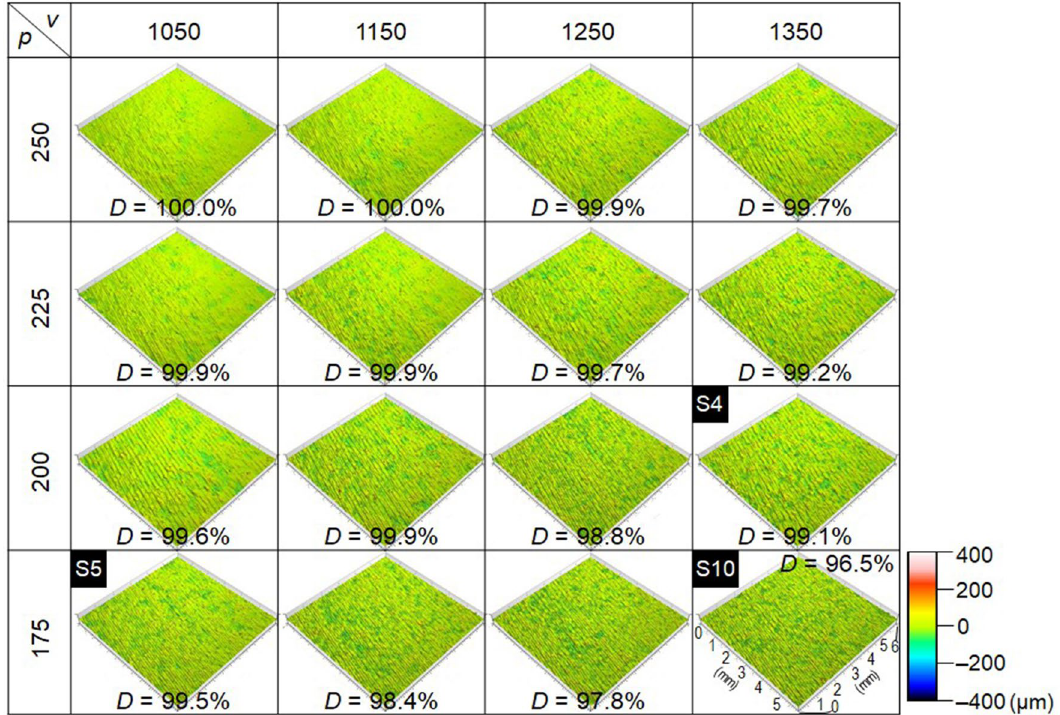
Figure 5. CSI images of specimens in regions of low power and low scan speed. Images created using TalyMap Plutinum Ver.6.2.7029 (https:// www. taylor- hobson.